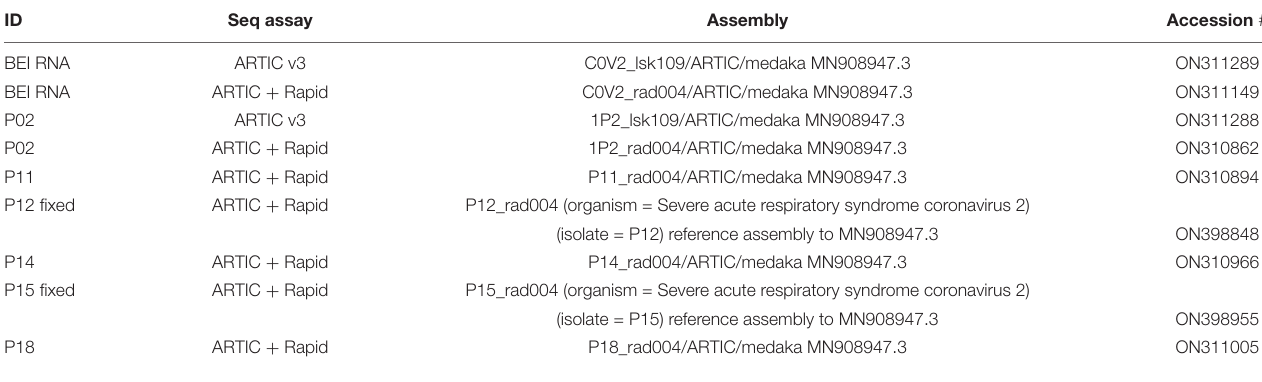
TABLE 3 | Assemblies with GenBank accession